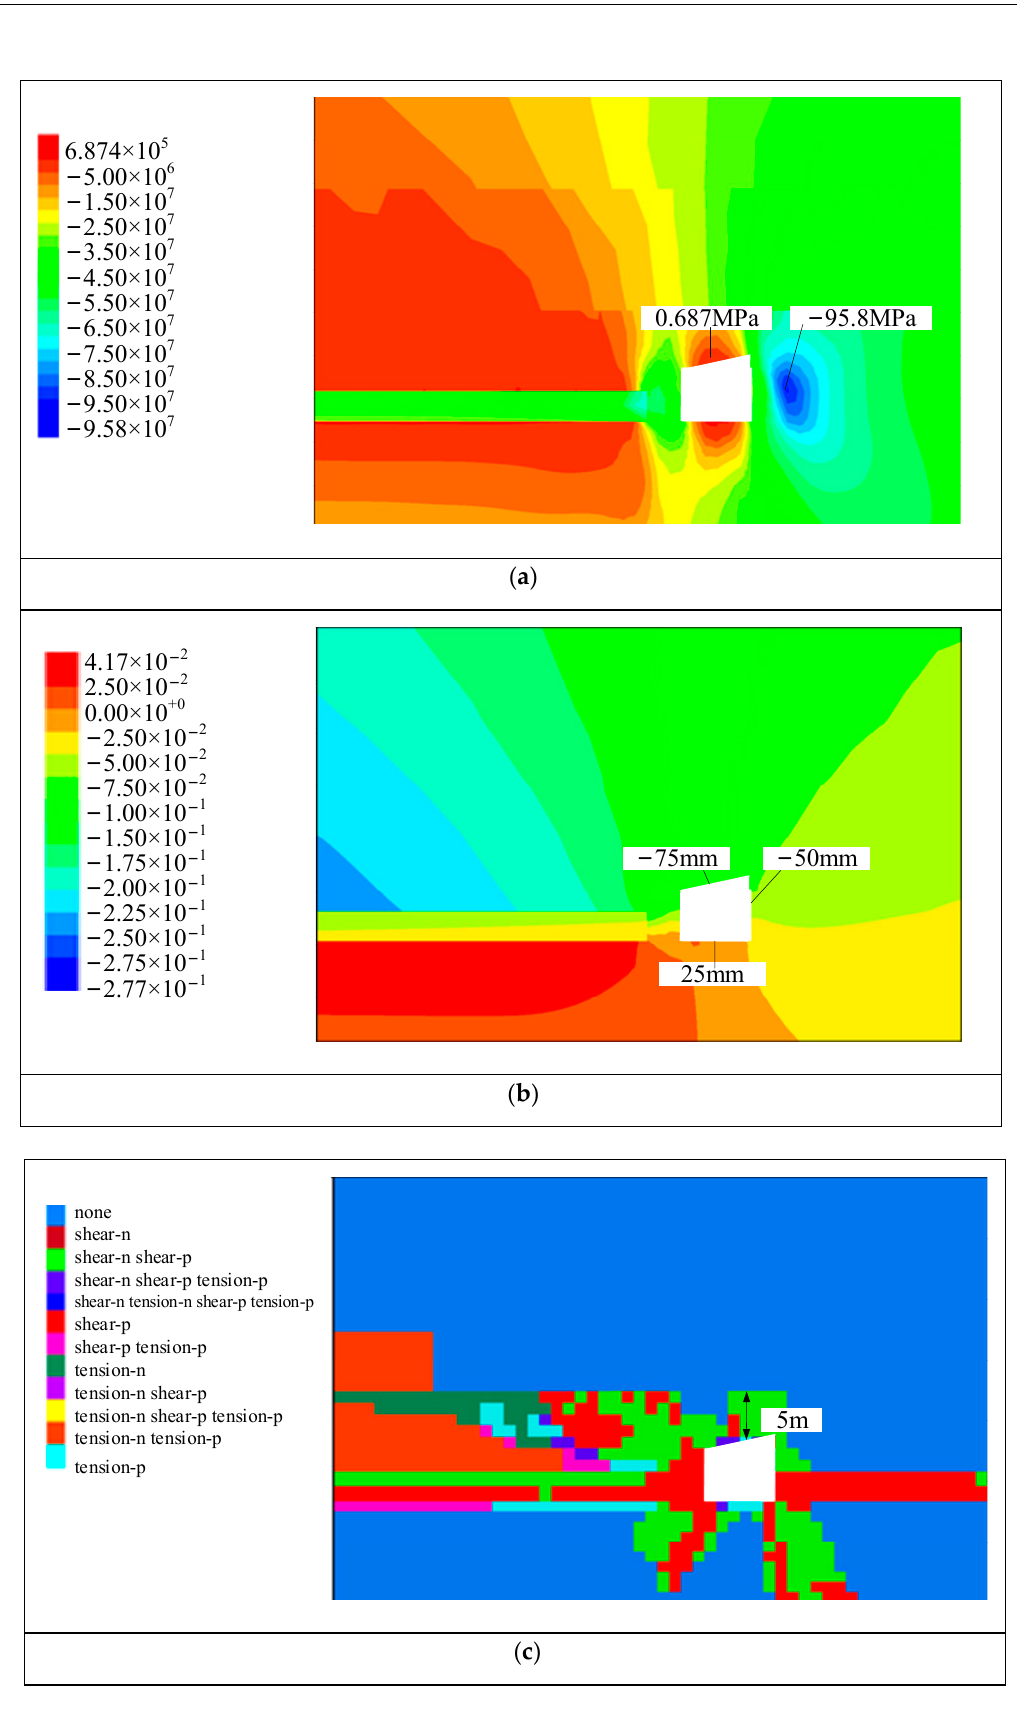
Figure 4. Tertiary support sectional drawing: ( a ) primary support, ( b ) secondary support, ( c ) tertiary support.